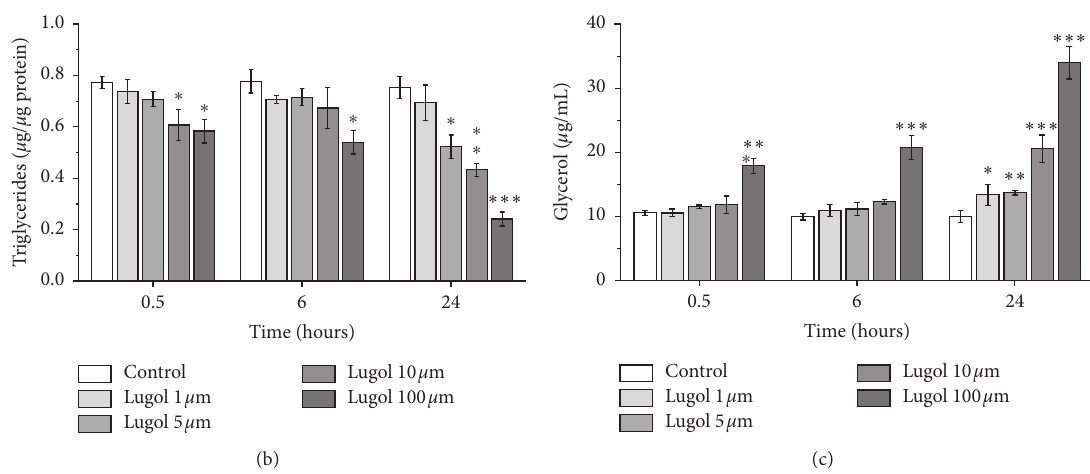
Figure 2: Effect of lugol on lipolysis in mature 3T3-L1 adipocytes. Mature 3T3-L1 adipocytes were treated in the serum-free medium with 1–100 µ M of lugol for 0.5, 6, and 24h. (a) Micrographs of cells stained with Oil Red O and quantification; (b) triglyceride content and (c) lipolytic activity were measured from the amount of glycerol in the culture medium. Data are mean ± SD values from three experiments with triplicate determination. ∗ P < 0 . 05, ∗∗ P < 0 . 01, and ∗∗∗ P < 0 . 001 vs control (vehicle) cells ( n � 9). Scale bar is 100 µ